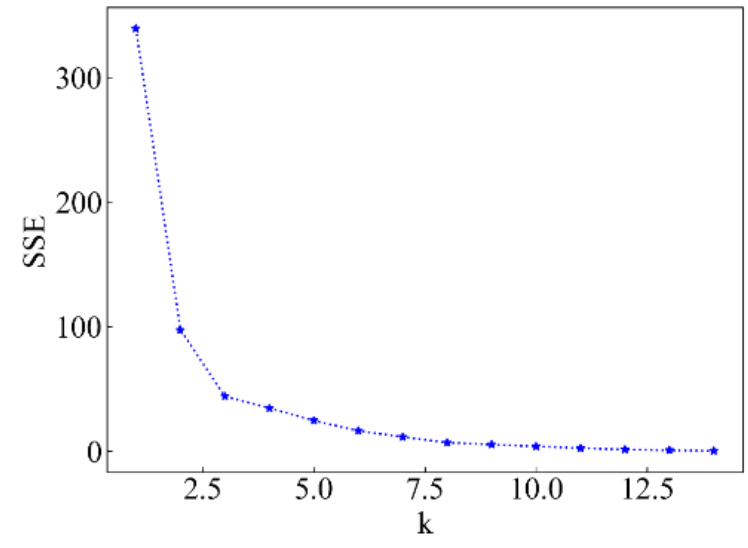
Figure 2. The relationship between SSE and the number of classes. Table 2. Summary of clustering results.